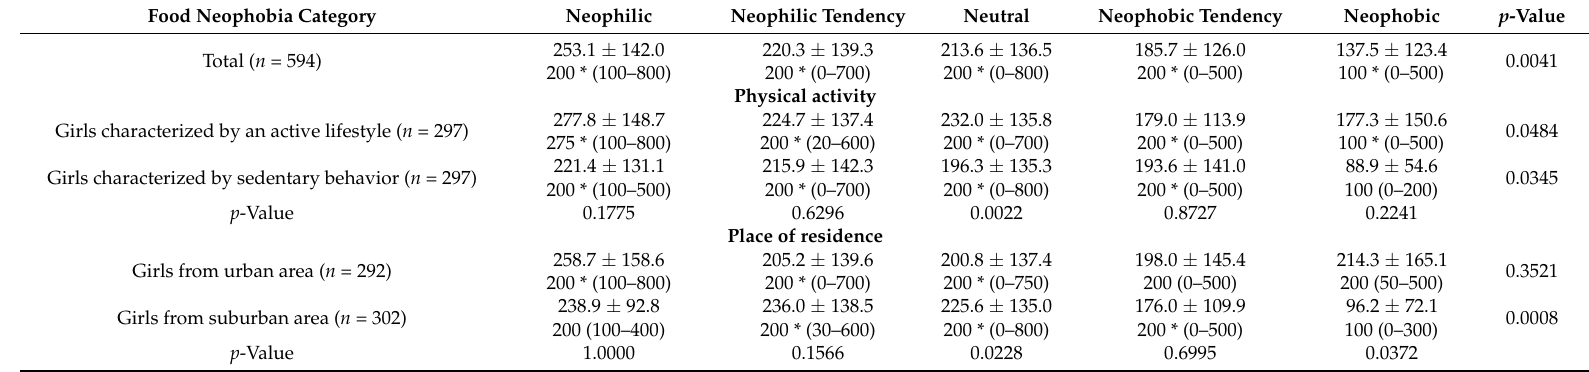
Table 4. Fruit intake (g/day) for girls in Food Neophobia Scale categories—mean ± SD, as well as median, minimum, and maximum values are presented for food neophobia categories and compared between subgroups characterized by an active lifestyle ( n = 297) and by sedentary behavior ( n = 297), as well as from urban area ( n = 292) and suburban area ( n =